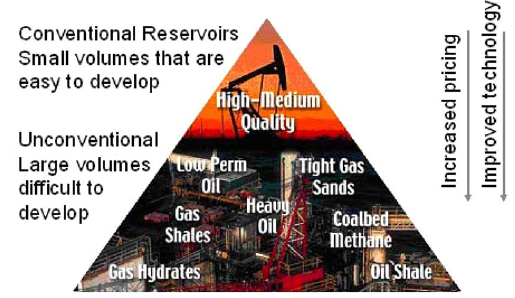
Fig. 1 Hydrocarbon resources triangle (Adapted from Martin et al. 2010)